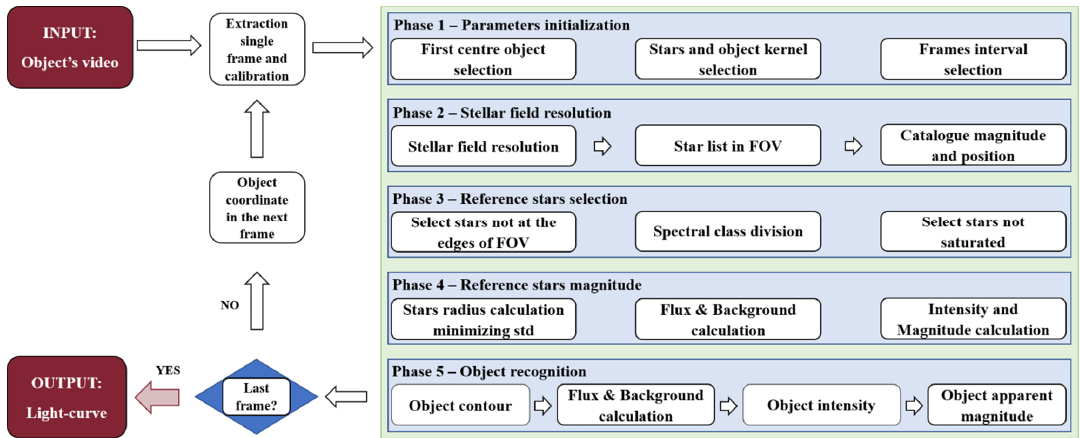
Figure 6. Video analysis software flow chart.